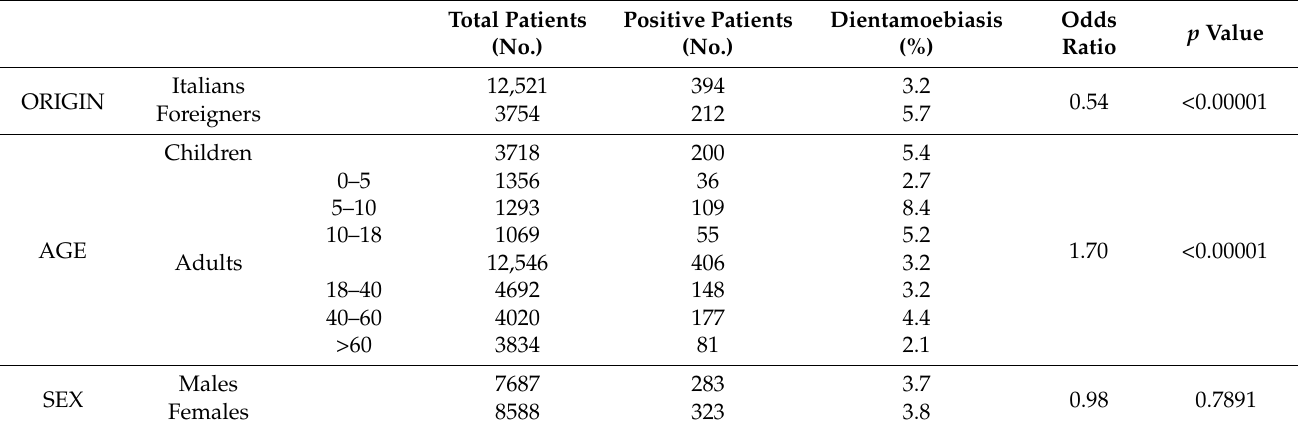
Table 2. Statistical analysis concerning the origin, age, and sex of the patients diagnosed with dientamoebiasis.